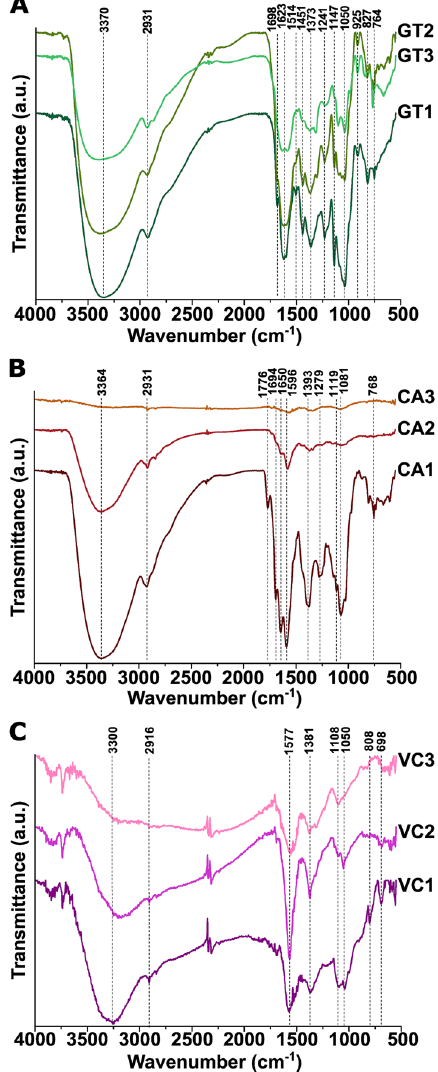
Fig. 1 FT-IR spectra of extracts obtained by first, second, and third extraction rounds of green tea (GT1–GT3) ( A ), coffee (CA1–CA3) ( B ), and Virginia creeper extract (VC1–VC3) ( C